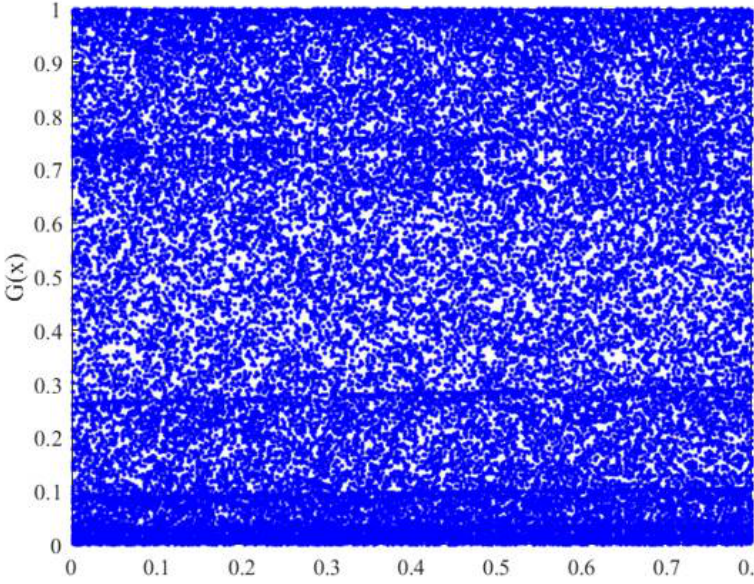
Figure 2. Bifurcation of the SET chaotic system when c = 2.8316.